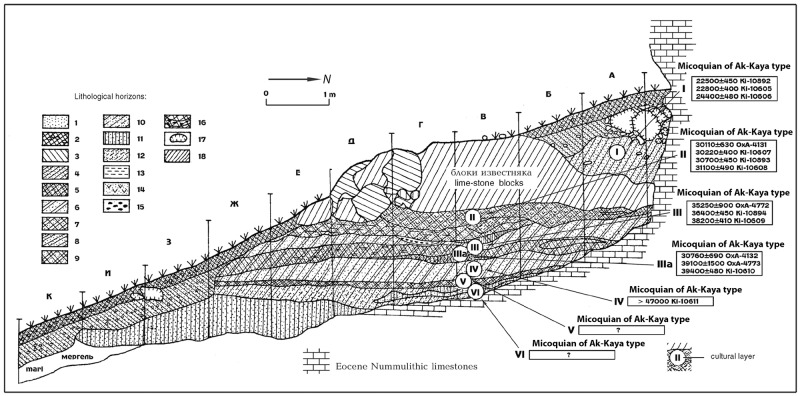
Stratigraphy of Zaskalnaya VI, Crimea.From: [58]–Fig 3.